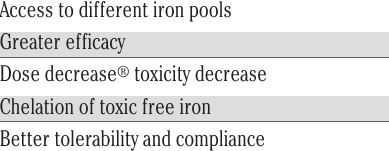
Table 4. Potential advantages of combina- tion therapy.